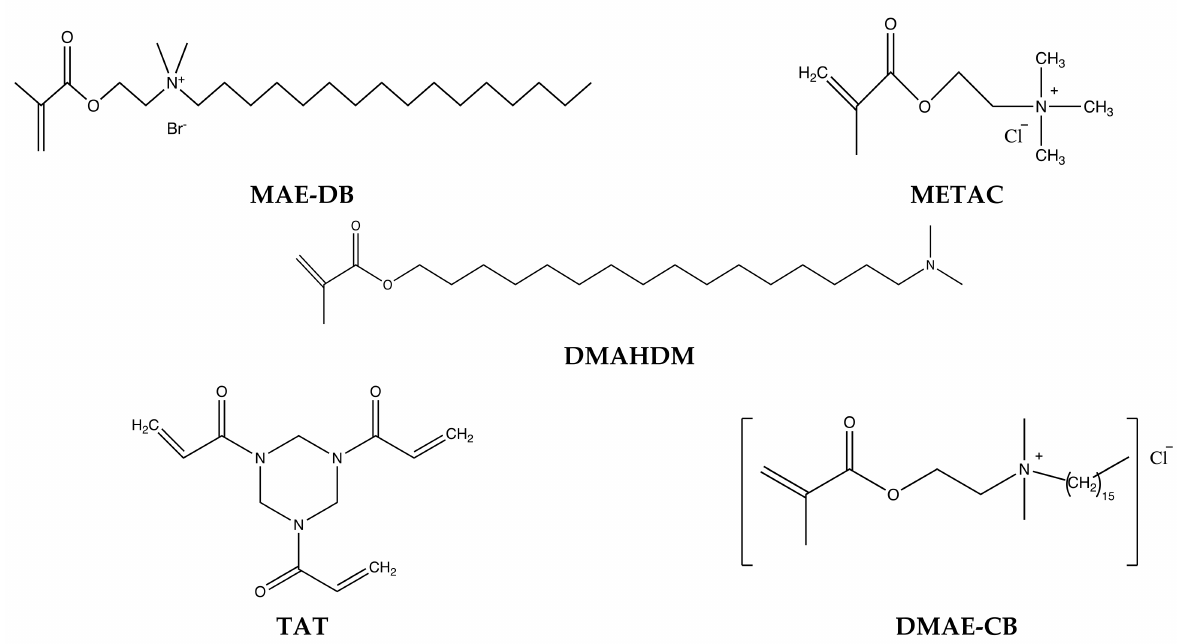
Figure 3. Chemical structures of Quaternary Ammonium Compounds (QACs). 2-methacryloxylethyl dodecyl methyl am- monium bromide (MAE-DB), 2-methacryloyloxyethyl trimethylammonium chloride (METAC), dimethylamino- hexadecyl methacrylate (DMAHDM), 1,3,5-triacryloyl hexahydro-1,3,5-triazine (TAT), methacryloxylethyl cetyl dimethyl ammonium chloride